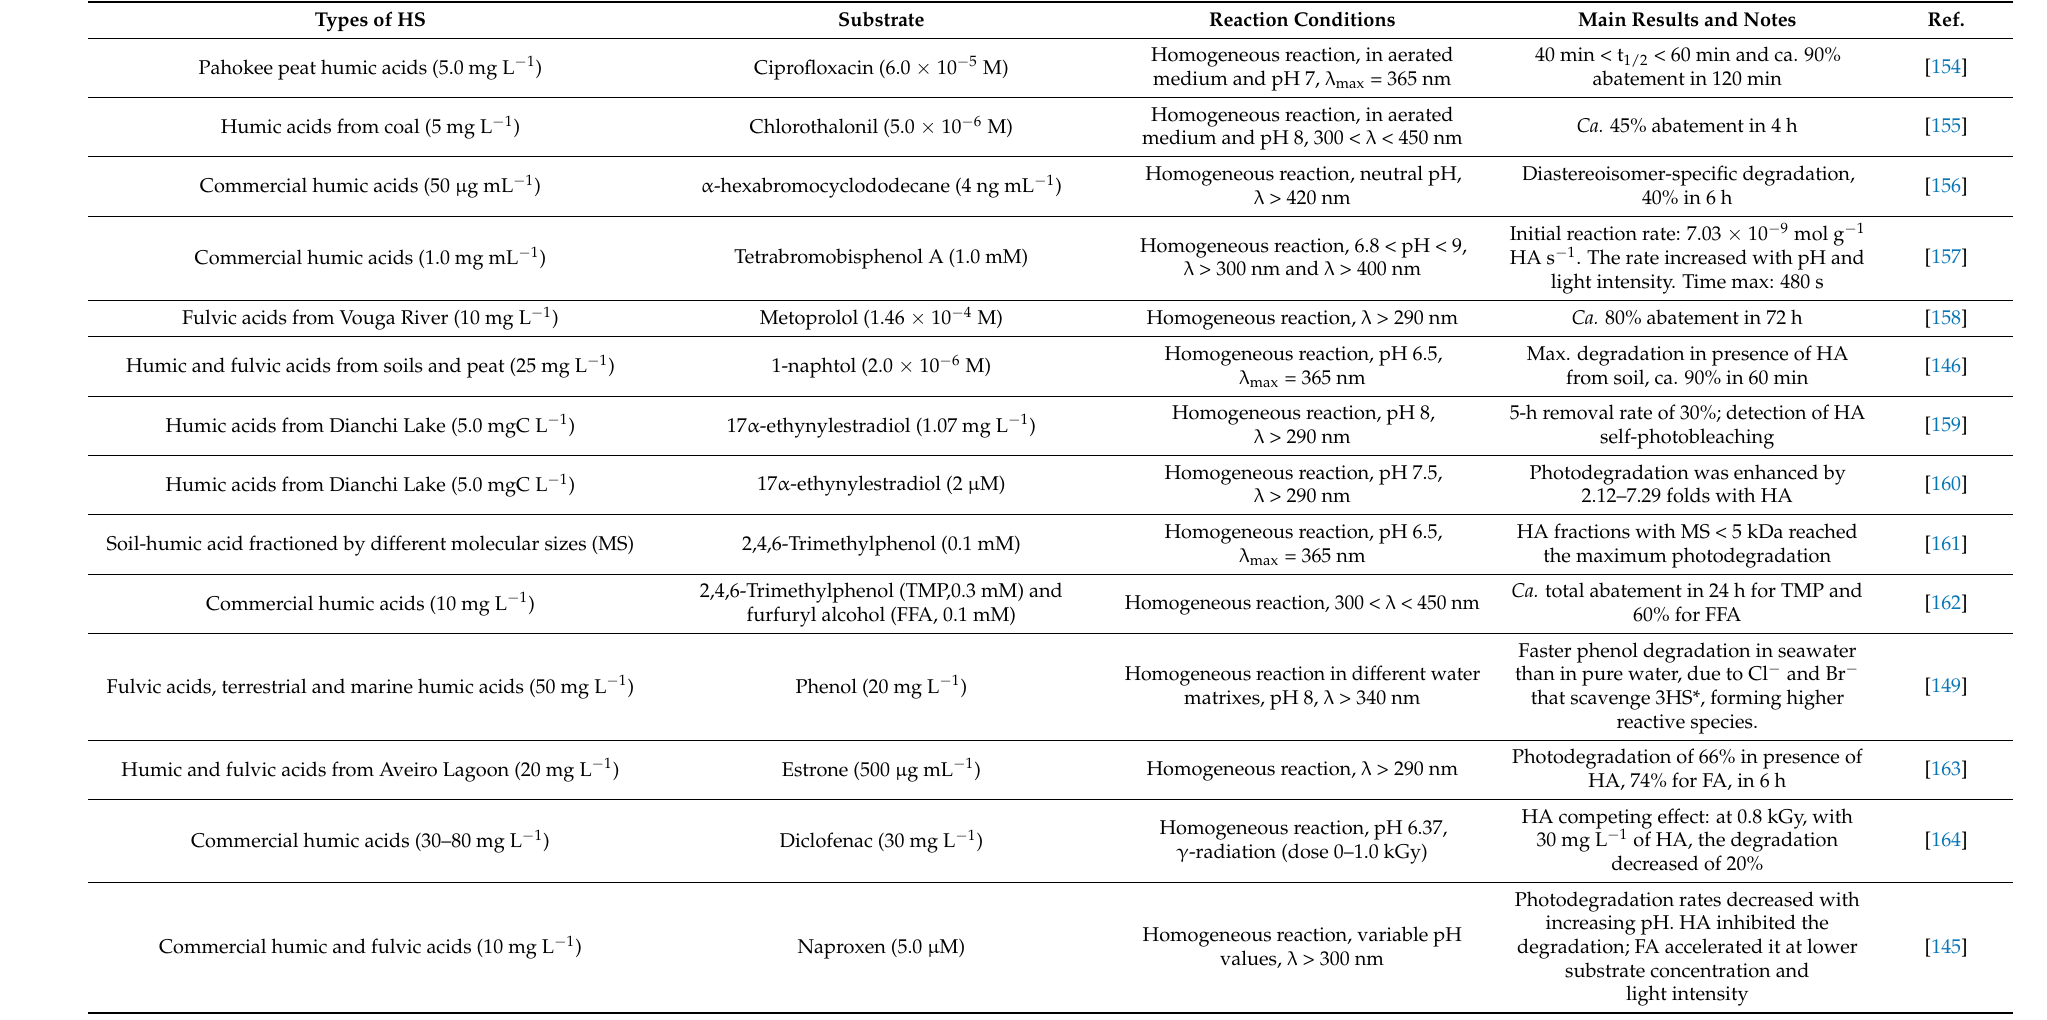
Table 5. Different HS-based systems for the degradation of water pollutants. The experimental conditions and main results are